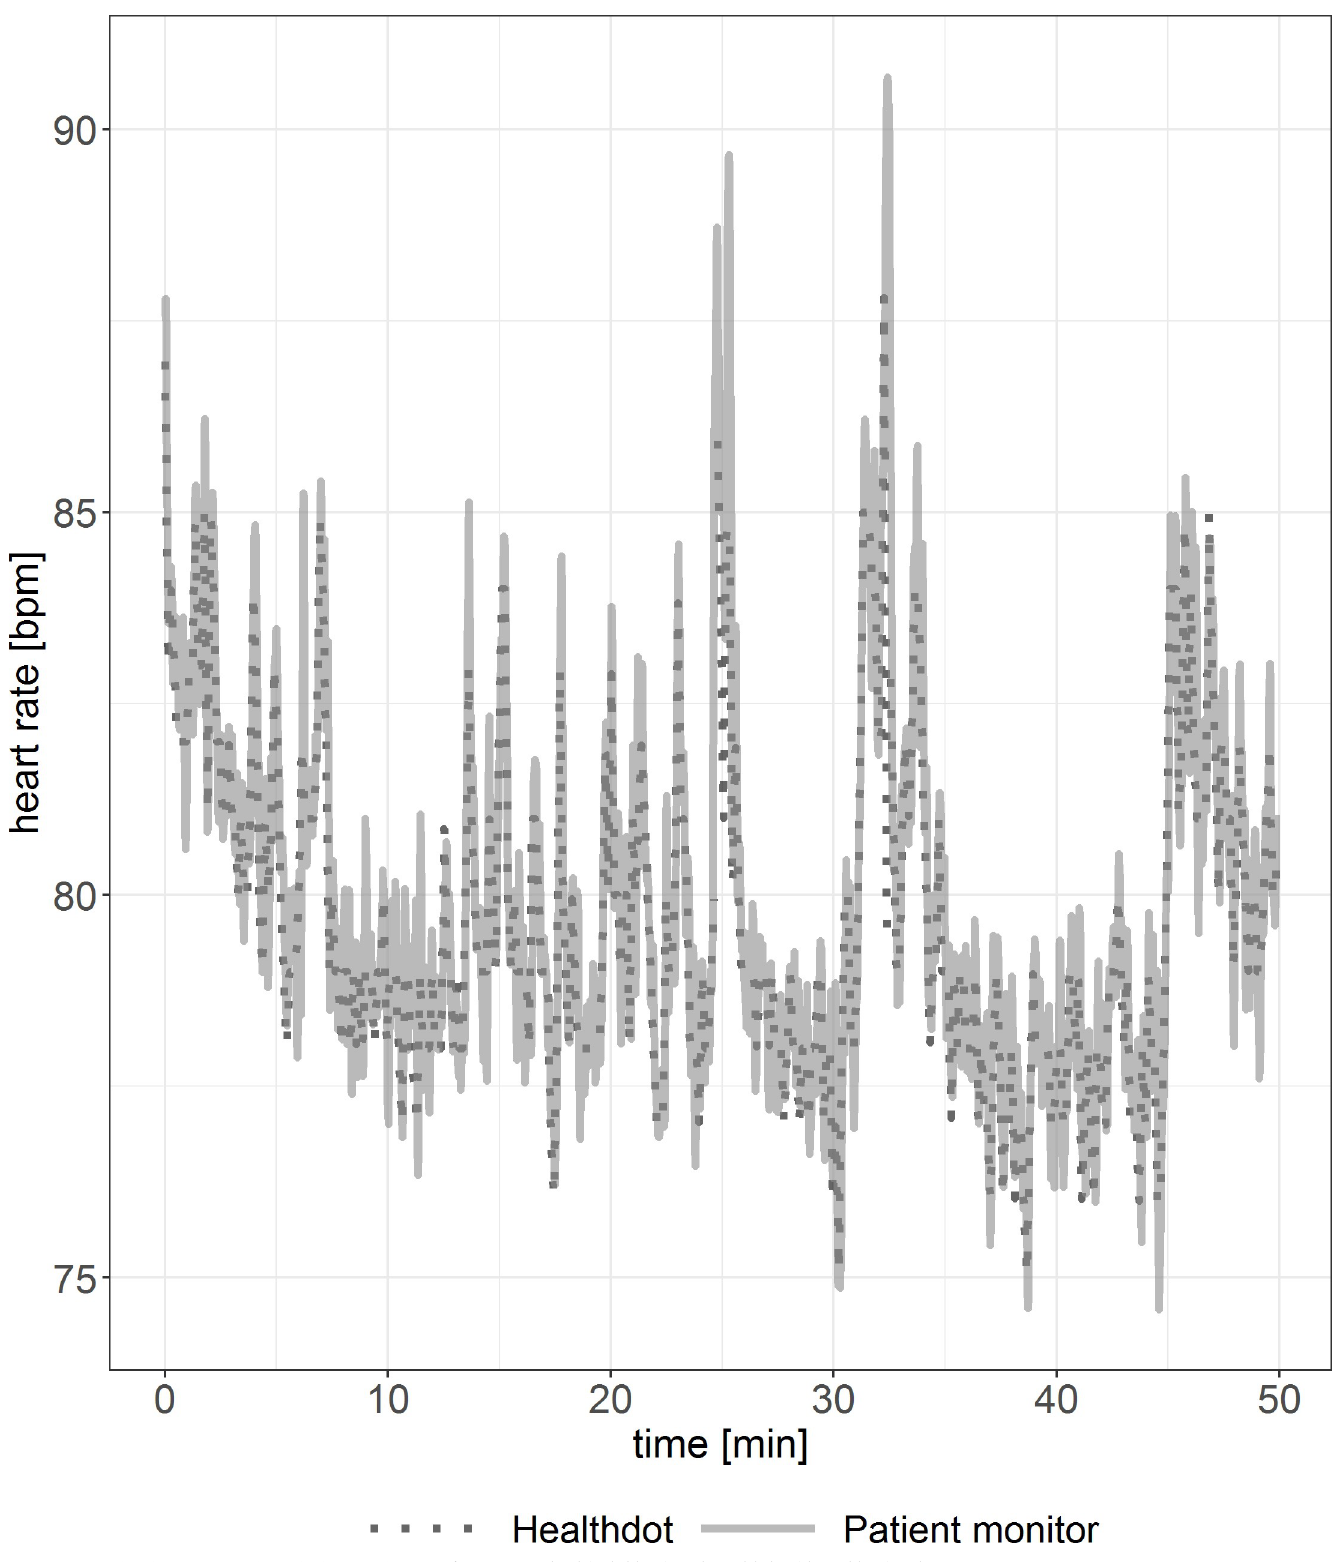
Fig 3. Example of HeartR vitals including outliers. Reference standard (solid line) and Healthdot (dotted line) in bpm.